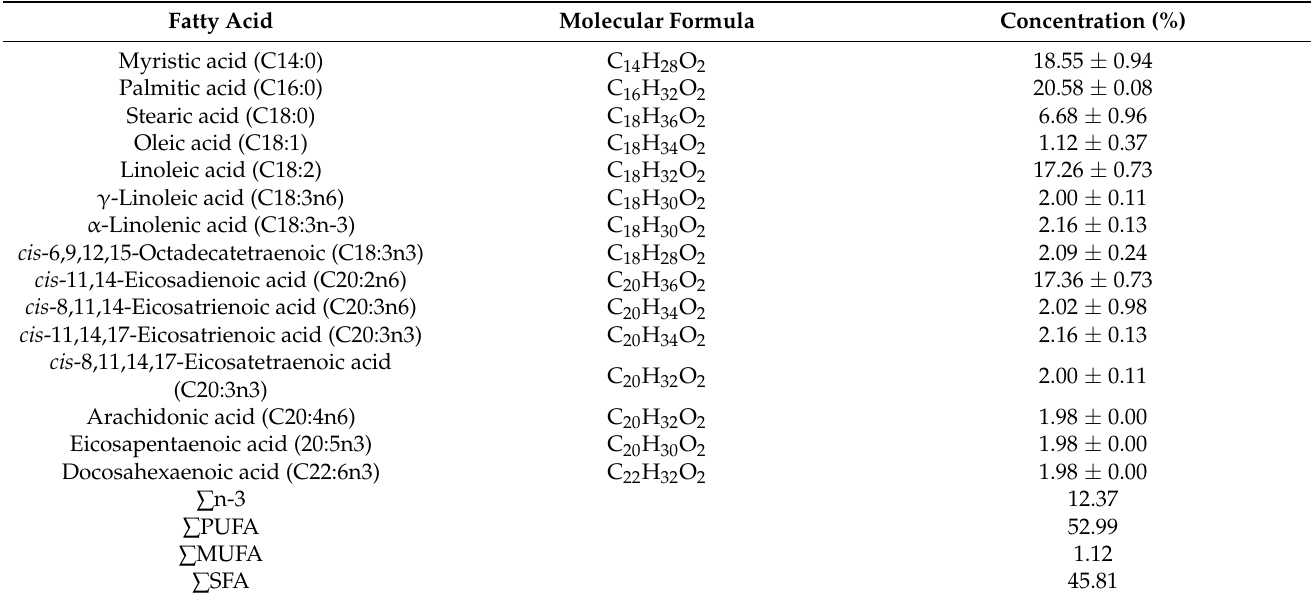
Table 1. Fatty acid composition of Chlorella sp. S14.